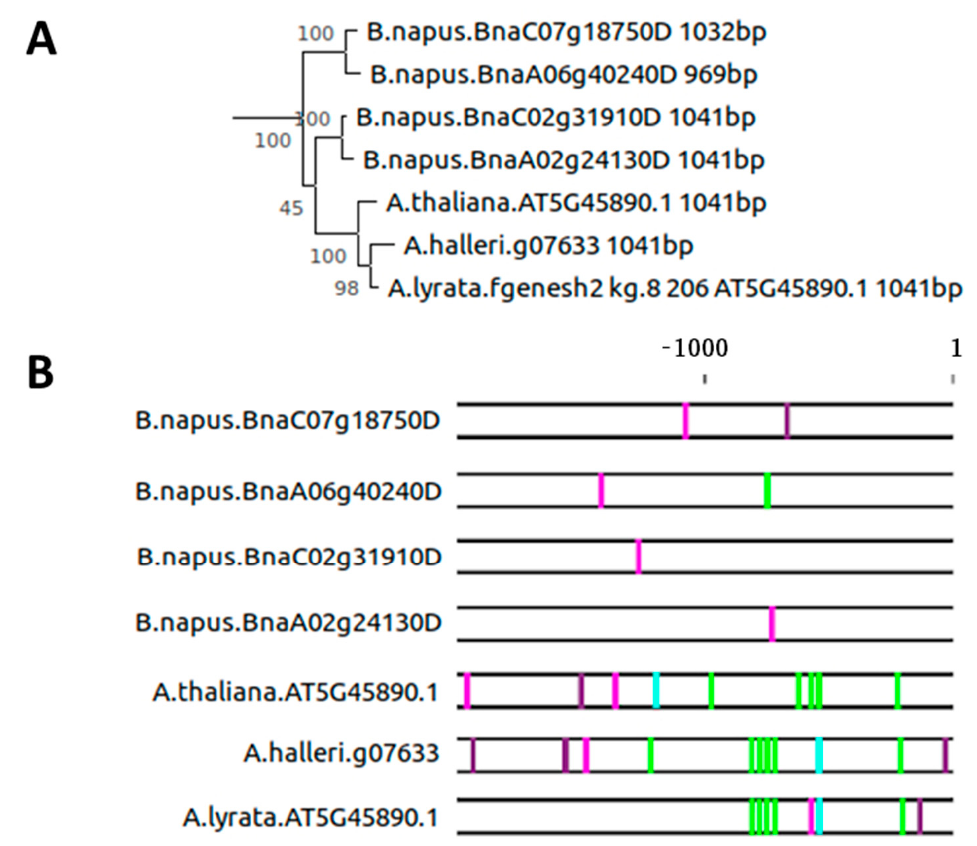
Figure 3. Phylogenic analyses of SAG12 and its promoter region in Brassicaceae. ( A ) Phylogeny of SAG12 coding sequence, gene identification numbers, and sequence length. ( B ) 2000 bp region 5 ′ adjacent to the ATG start codon annotated for the presence of W-boxes (T/CTGACT/C), A-boxes (TACGTA), T-boxes (AACGTT), C-boxes (GACGTA), and G-boxes (CACGTA). W-boxes in sense (Pink), W-boxes in anti-sense (Purple), A-boxes (Green), and T-boxes (Cyan). In the genome of the poplar ( Populus trichocarpa) tree, seven orthologs of SAG12 are found in relatively close proximity on chromosome 4 (Figure 4A). Genes POPTR 004G056000v3, POPTR 004G056100v3, POPTR 004G056200v3, POPTR 004G056300v3, and POPTR 004G056500v3 have almost identical coding regions, even though their lengths vary between 918 bp and 1023 bp. The main cause for their differences in length are deletions of various lengths in the 5 (cid:48) end regions, in POPTR_004G056000v3, and POPTR_004G056200v3. The annotated regulatory elements in their promoters are similar, except for two